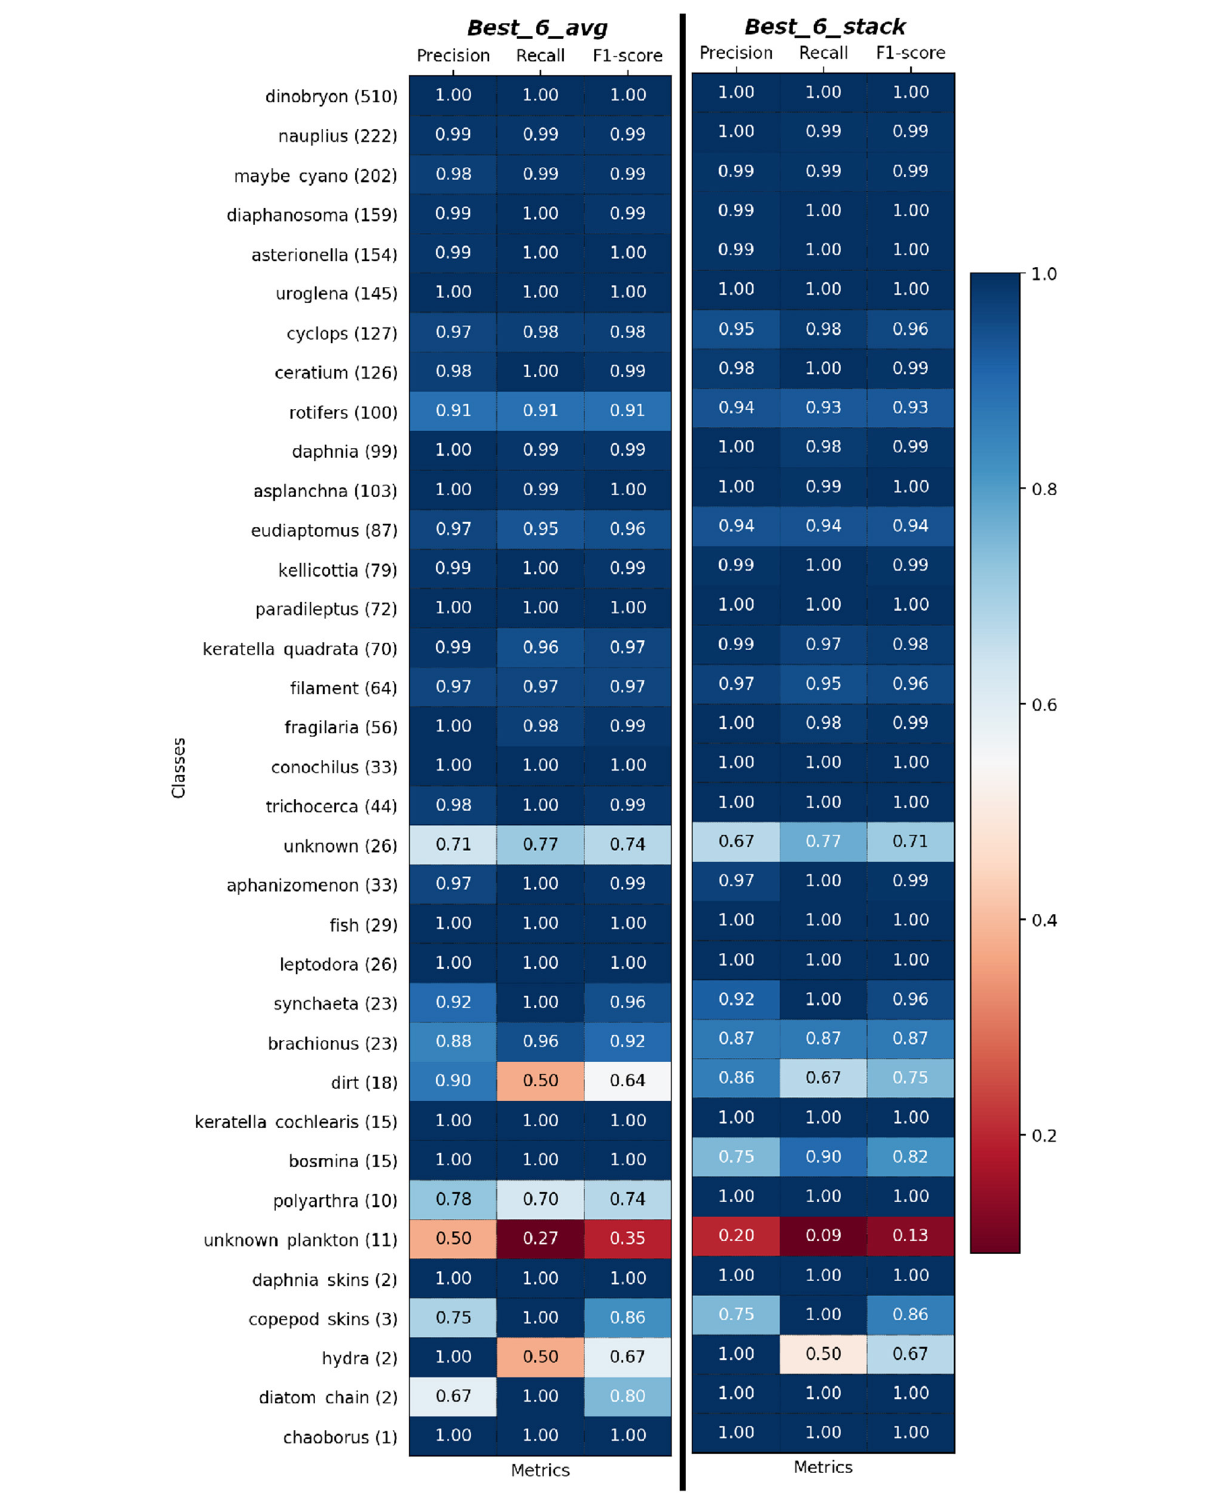
Frontiers in Microbiology |